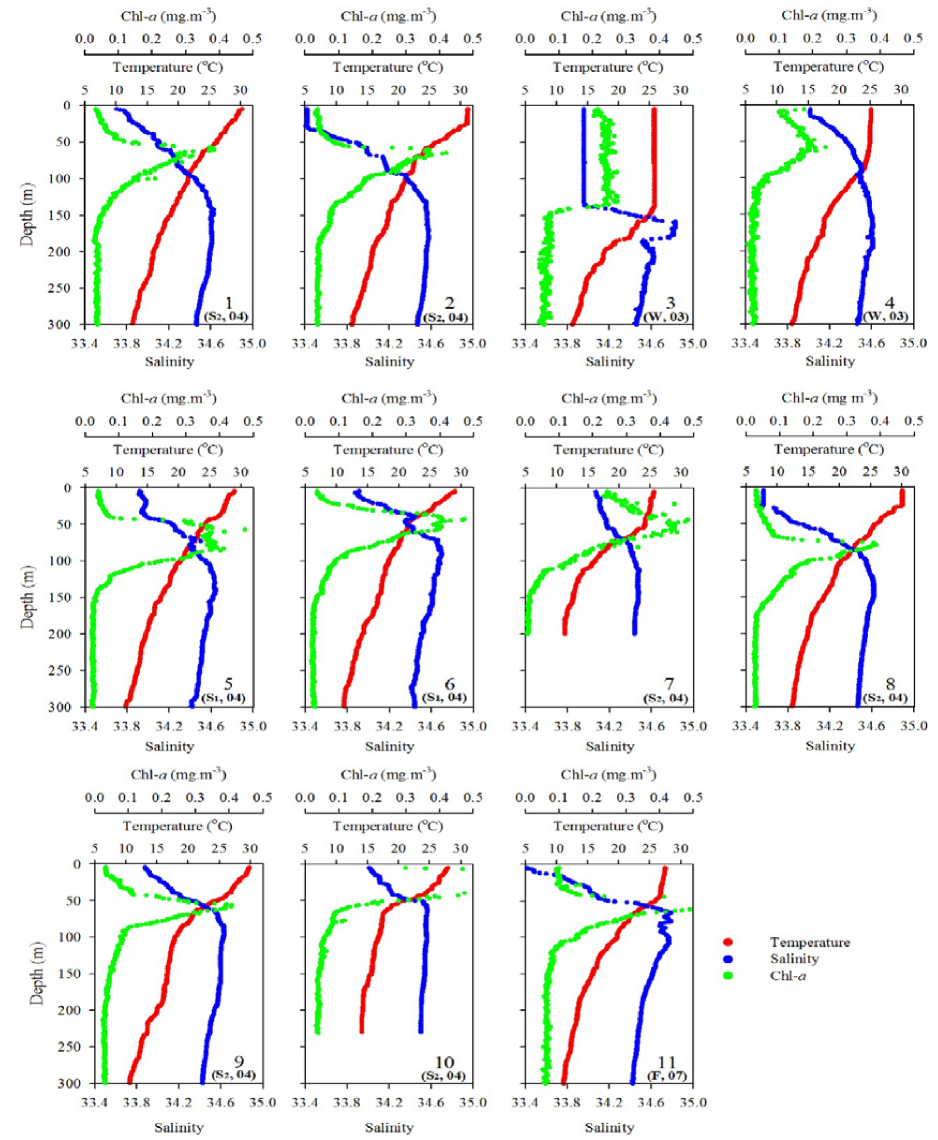
Figure 2. Vertical profiles of temperature, salinity, and fluorescence (Chl a ) in the upper layer (300m) of the water column for all sampling stations during various expeditions. The data of sampling season (S1: spring; S2: summer; F: fall; W: winter) and year (e.g., 04 for 2004) are included for each sampling